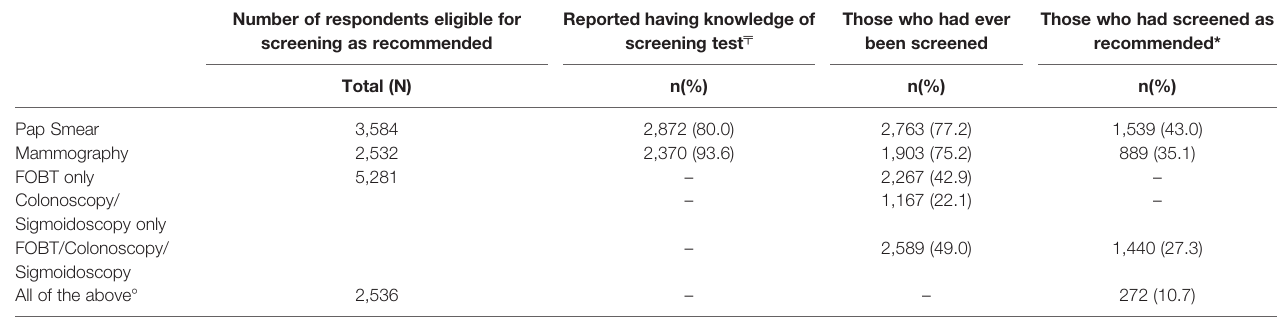
TABLE 2 | Cancer screening test knowledge and participation